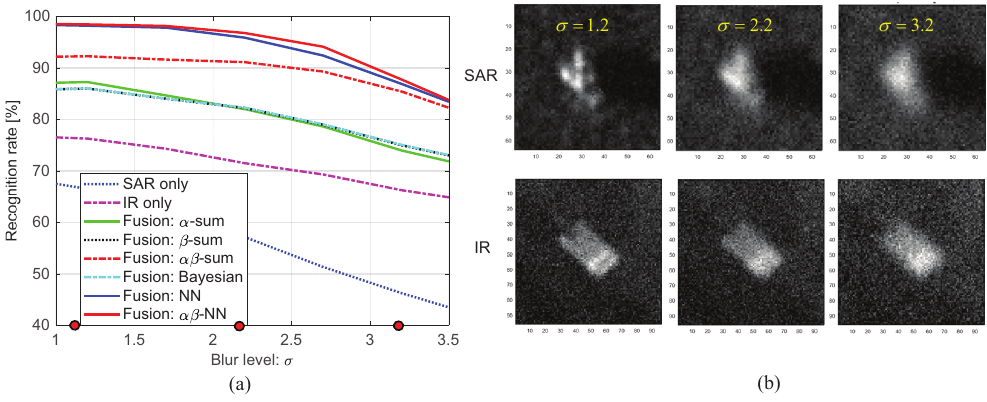
Figure 18. Performance evaluation results for blur variation: ( a ) recognition rate vs blurring level [ σ ]; ( b ) test examples of SAR and IR images at different blur